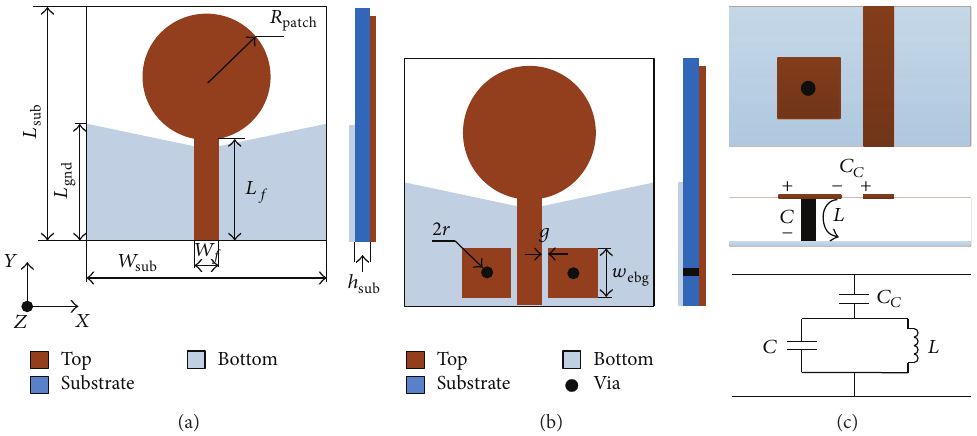
Figure 1: Proposed UWB antenna (a) without EBG structures and (b) with EBG structures and (c) equivalent circuit of WLAN notched based on EBG structures.